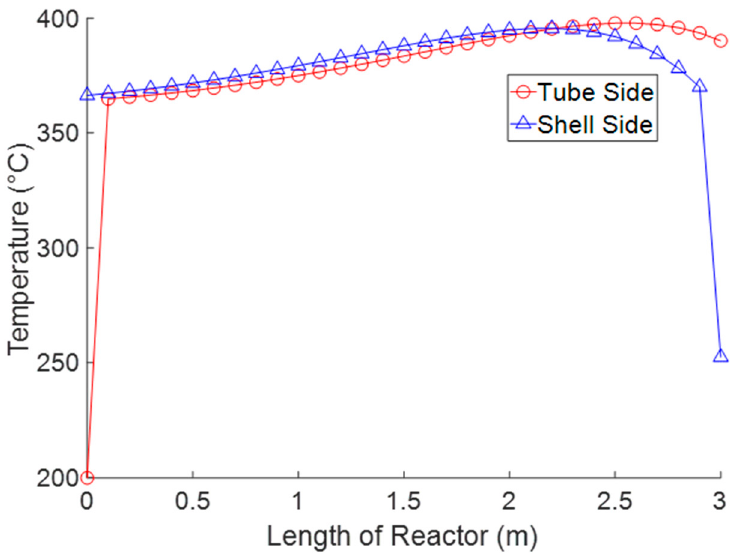
Figure 7. Temperature profiles of the tube and shell sides for nonisothermal operations.